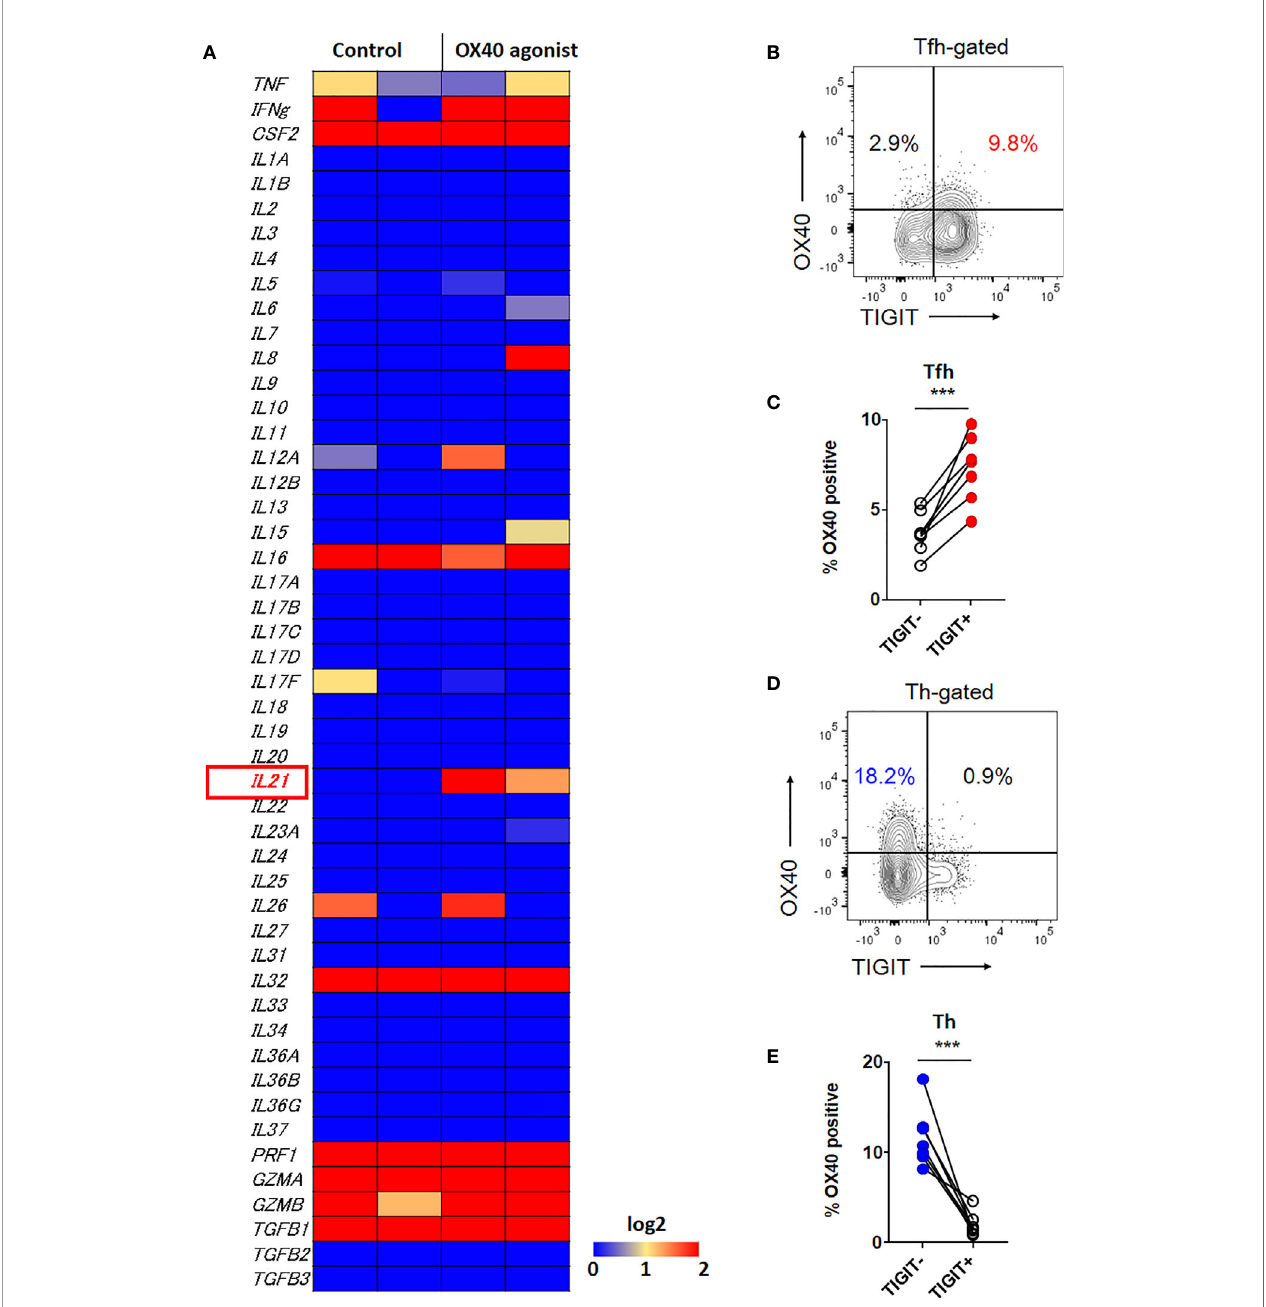
FIGURE 6 | OX40 signal is associated with IL-21 expression. (A) CD4 + T cells were stimulated in vitro in the presence of a CD3/CD28 activation beads with or without agonistic OX40 antibody for 3 to 5 days. Transcriptome analysis for 49 cytokines was obtained by RNA-sequencing, and the gene expression levels are shown as a heatmap. (B, D) OX40 expression level was examined in CXCR5+Tfh and CXCR5-Th cells by fl ow cytometry. (B, D) , representative image. (C, E) , multiple comparison results (n=7). (C, E) paired t-test.